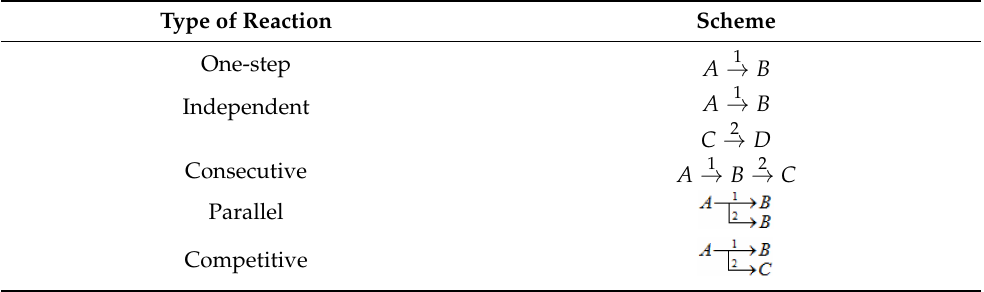
Table 2. Designations of basic types of reactions used in kinetic analysis on the example of two- stage